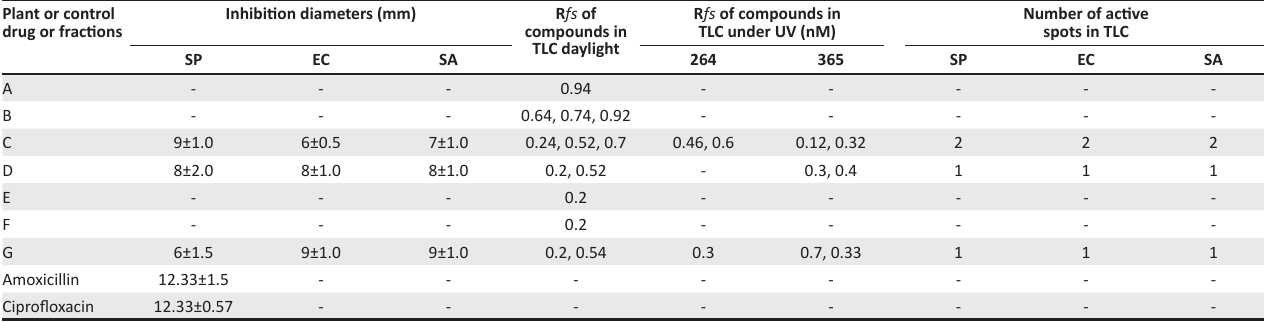
Inhibition diameters (mm) R fs of